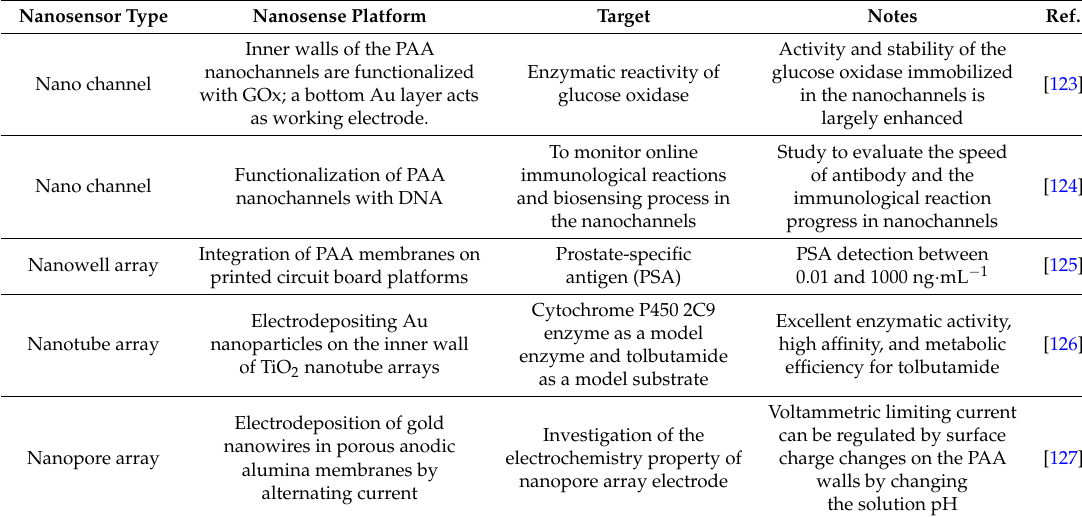
Table 3. Articles published in the years 2012–2016, dealing with biosensing application of arrays of nanochannels, nanopores and